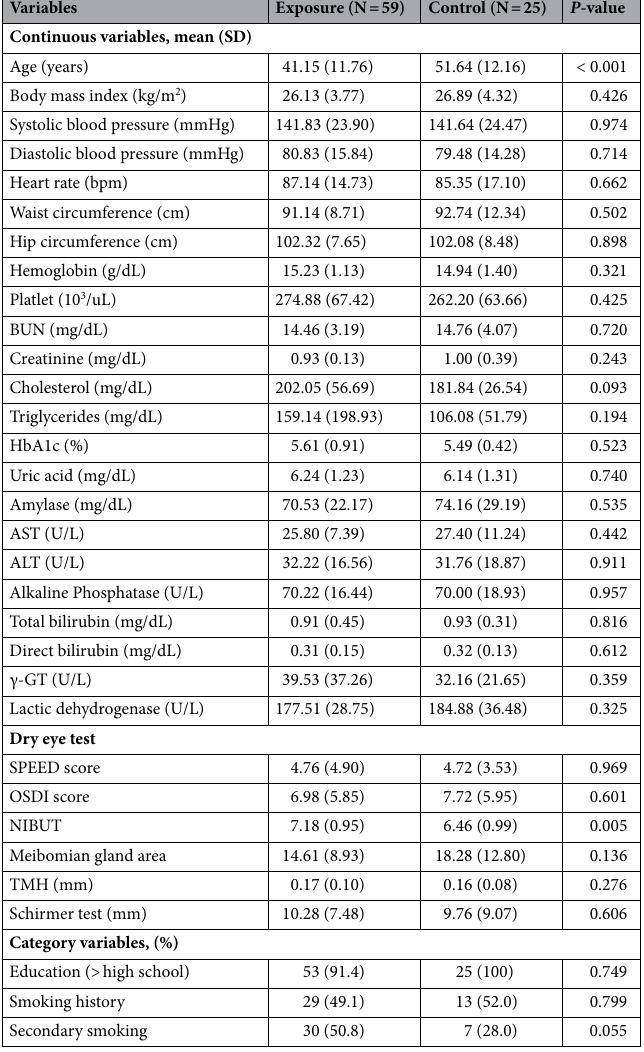
Table 1. Characteristics of study population. SPEED, standard patient evaluation of dry eye; OSDI, ocular surface disease index; NIBUT, noninvasive tear break up time; MGL, meibomian gland loss; TMH, tear meniscus